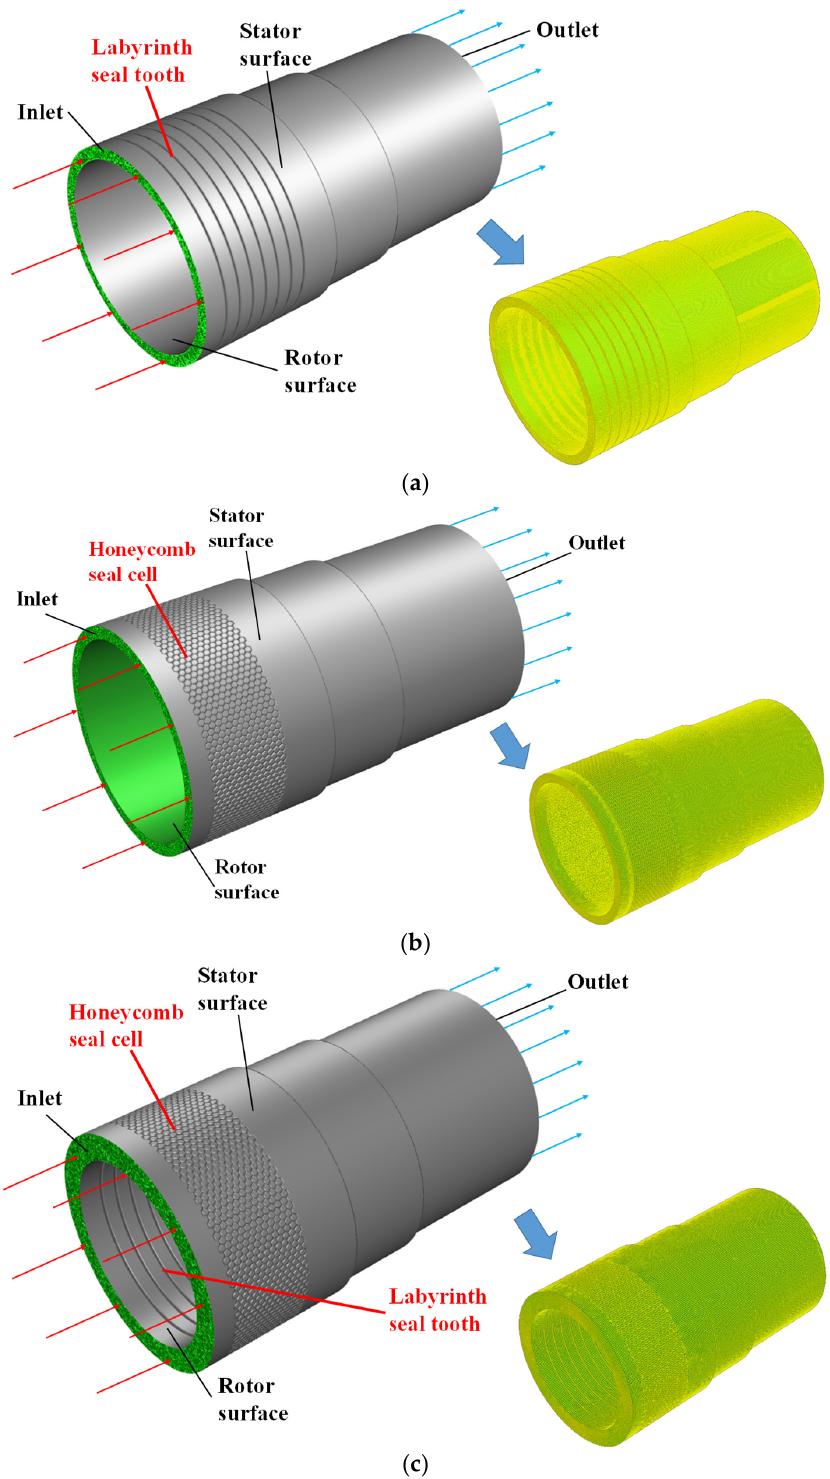
Figure 3. Seal flow field numerical models. ( a ) Labyrinth seal; ( b ) honeycomb seal; ( c ) hybrid labyrinth–honeycomb seal.